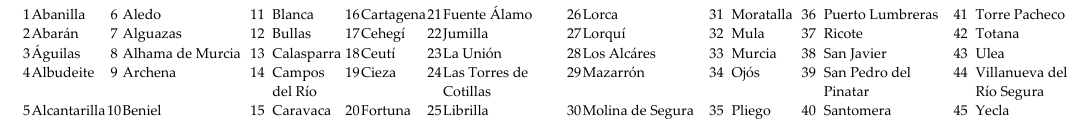
Figure 1. Positivity in 2019. ( A ) Municipalities (the numbers are related to the table of municipality names). ( B ) Sampling points. In each case, the Jenks natural breaks were calculated according each dataset. In red, the related municipalities to dengue cases in 2018, in the names list.